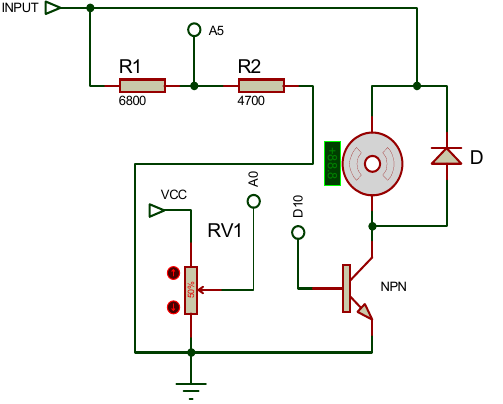
Figure 5. Voltage sensor circuit at load.